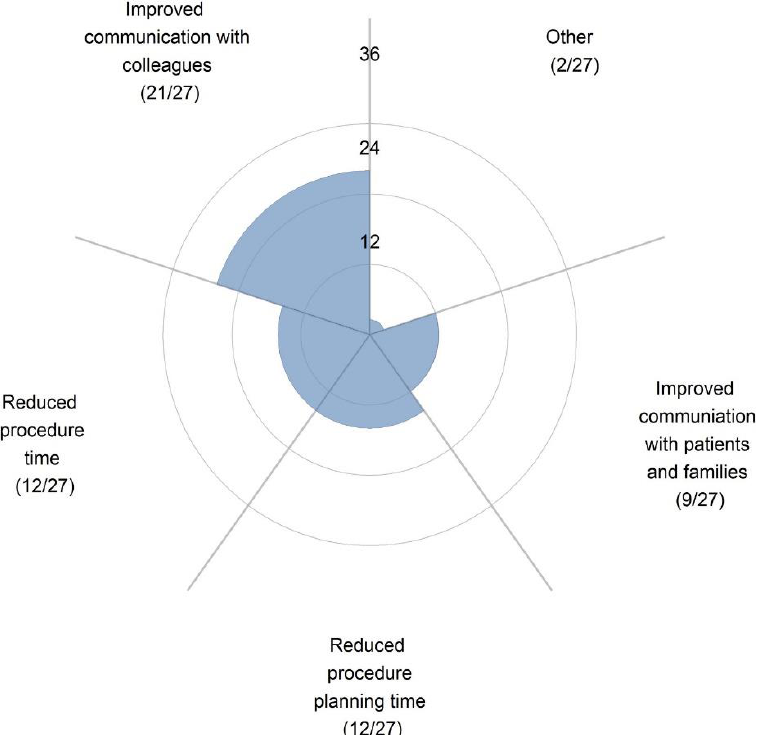
Figure 14. Survey responses show that 3D-printed models were most useful in improving communication with colleagues. Reprinted with permission under the open access from Illmann et al. [50].